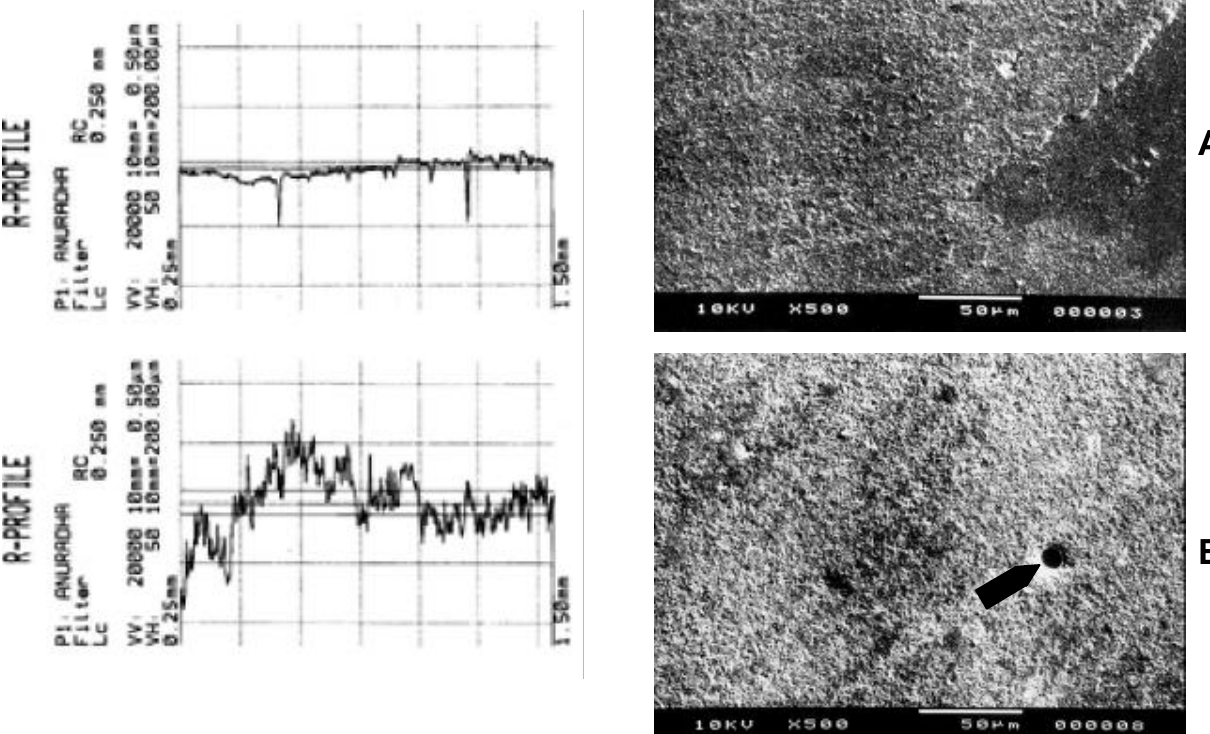
FIGURE 3 - Roughness and microscopic evaluation of Variolink II (Vivadent) resin cement before (a) and after (b) brushing